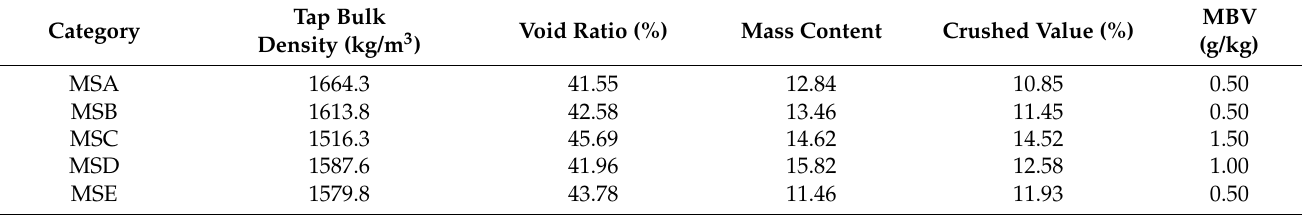
Figure 3. Gradation curves of six sands. The mixtures of concrete are shown in Table 4. It should be emphasized that the five types of manufactured sand used to prepare concrete were adjusted according to the DES grading shown in Figure 3. All of the stone powers were uniformly replaced by the stone powder in MSA to prevent gradation and MBV from affecting the concrete’s performance. Table 4. Mix proportions of concrete (kg/m 3 ). Notation Cement Fly Ash Re-Crushed Stone Manufactured Sand Water Superplasticizer MF1